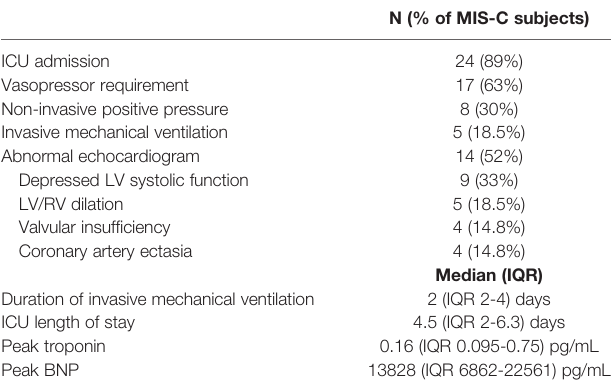
TABLE 2 | MIS-C subject clinical